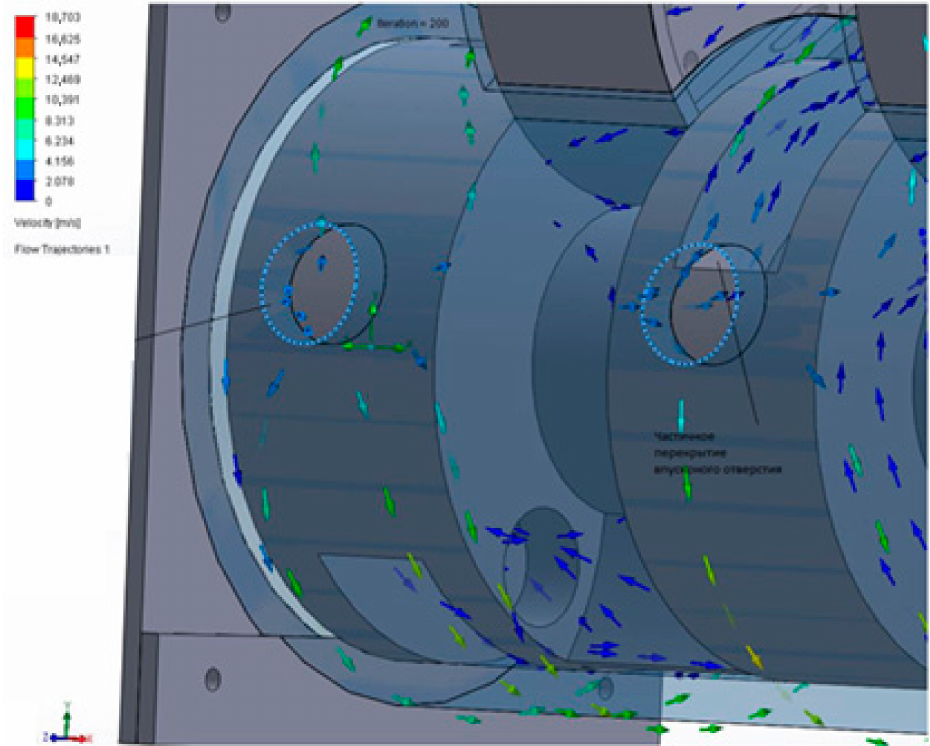
Figure 21. Full and partial overlap of the inlet hole of the structure.